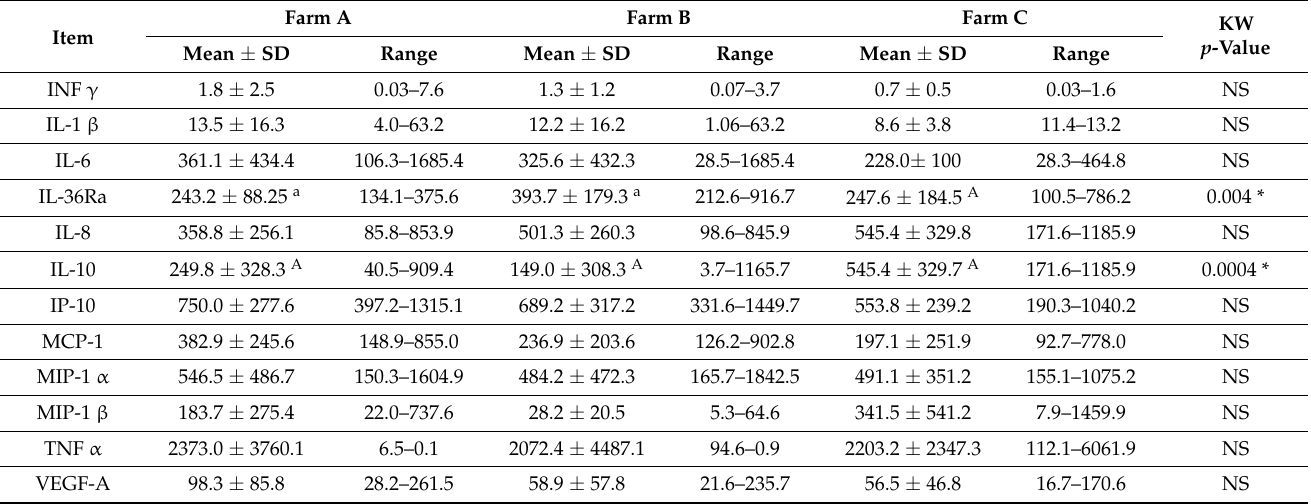
Table 5. Immunological parameters in lactating cows: estimated mean ± standard deviation and